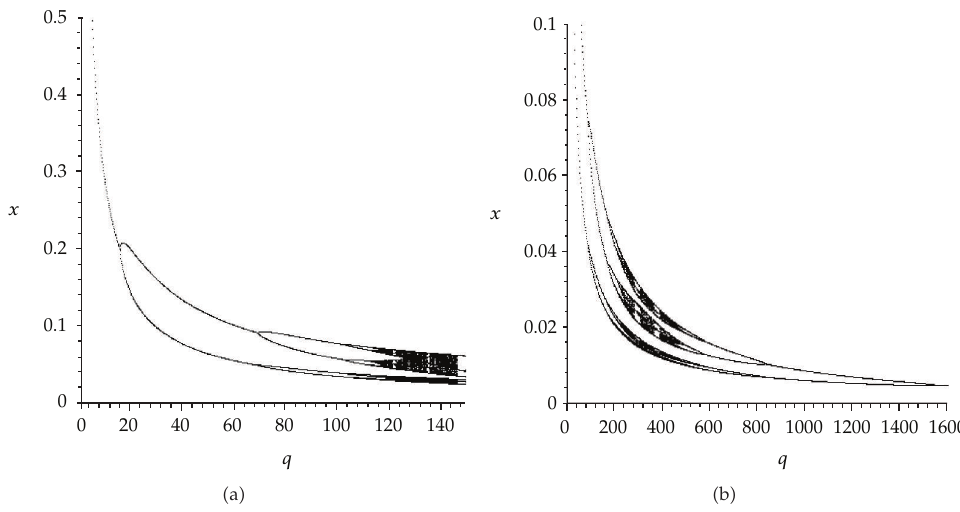
Figure 5: The bifurcation diagram for (cid:4) 2.1 (cid:5) , with α (cid:8) 0 . 5 , p (cid:8) 2, as q is growing (cid:4) a (cid:5) and for the perturbed model (cid:4) 4.6 (cid:5) with α (cid:8) 0 . 5 , p (cid:8) 2 , and λ (cid:8) 0 . 2 (cid:4) b (cid:5) . We see that there is a deterministic chaos in (cid:4) 2.1 (cid:5) for q large enough, while the perturbed model experiences chaos and then (cid:4) as q grows (cid:5) the break of chaos through period-halving